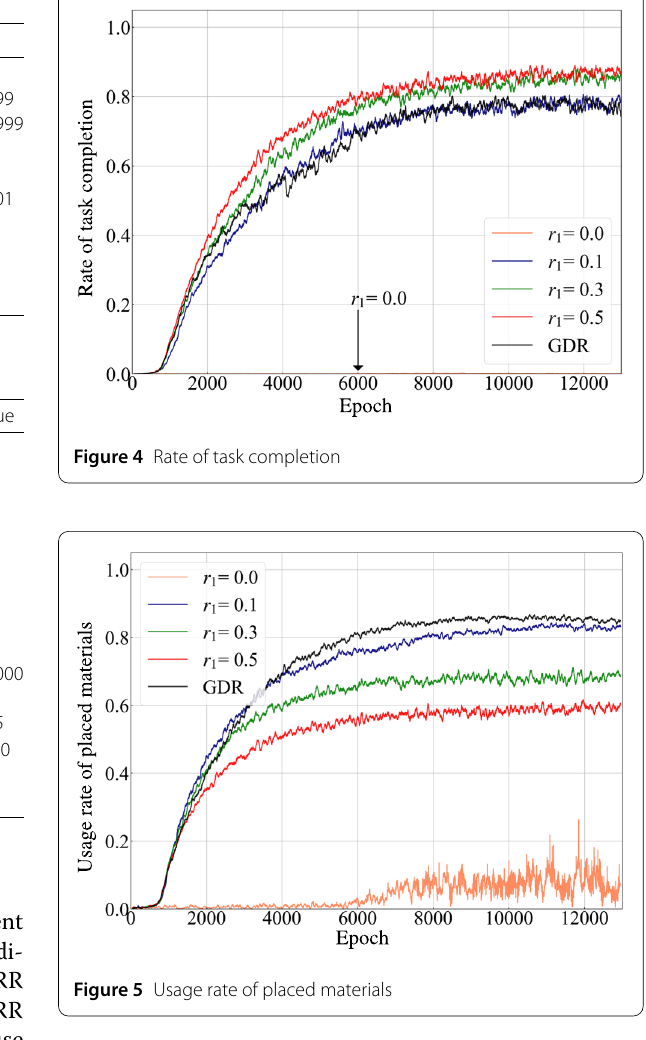
Table 2 Learning parameters